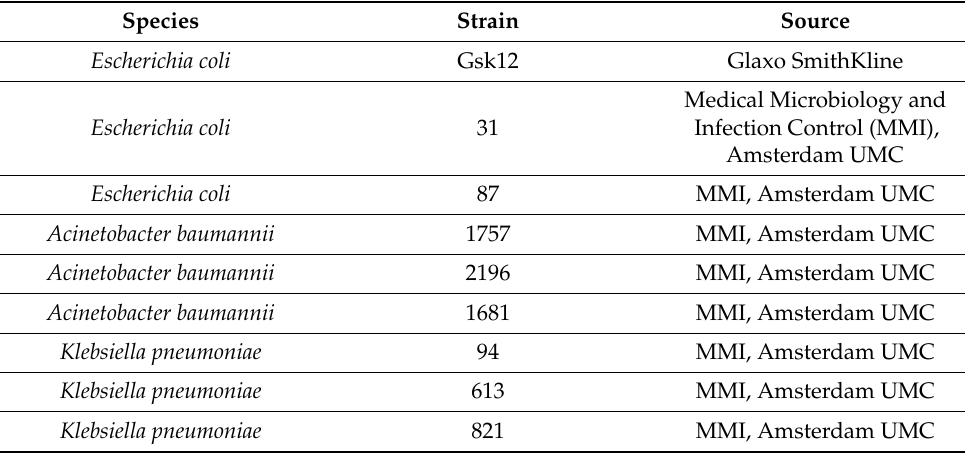
Table 1. Bacterial strains used in this study. Species Strain Source